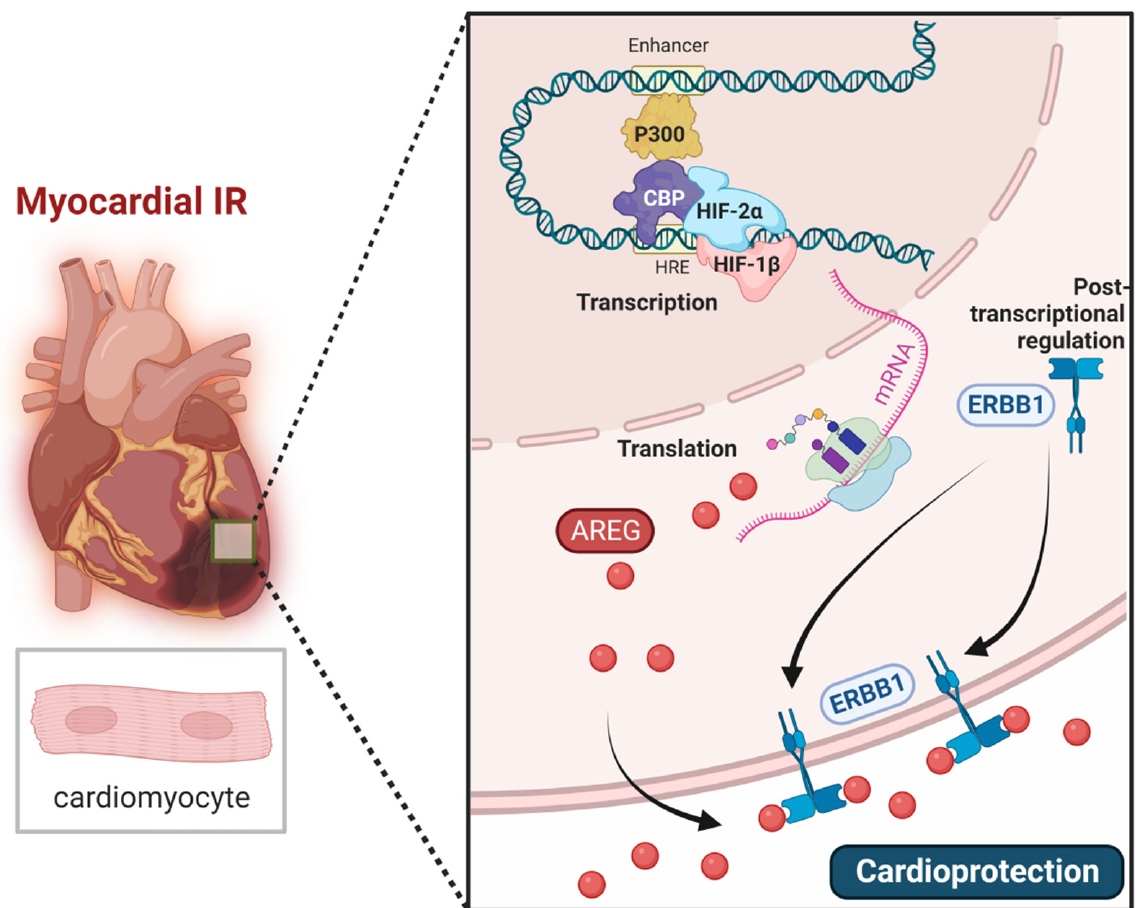
Figure 5. HIF2A induces AREG signaling in cardiac myocytes to provide cardioprotection. HIF2A contributes to cardioprotection during myocardial IR injury. The epithelial growth factor amphiregulin (AREG) has been identified as one of the target genes of HIF2A, which is significantly induced at both mRNA and protein levels in cardiomyocytes during hypoxia. HIF2A was also found to increase the expression of AREG receptor ERBB1 at the post-transcriptional level. These findings indicate HIF2A protects against myocardial IR injury through AREG signaling. ERBB: Epidermal growth factor receptor.